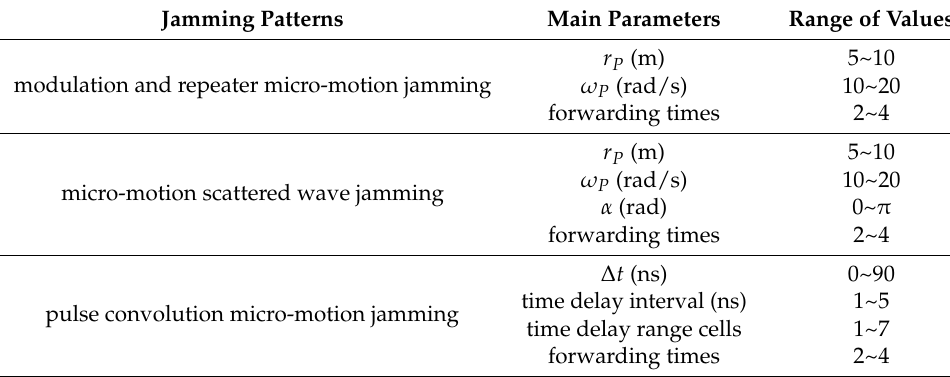
Table 1. Micro-motion jamming parameters.